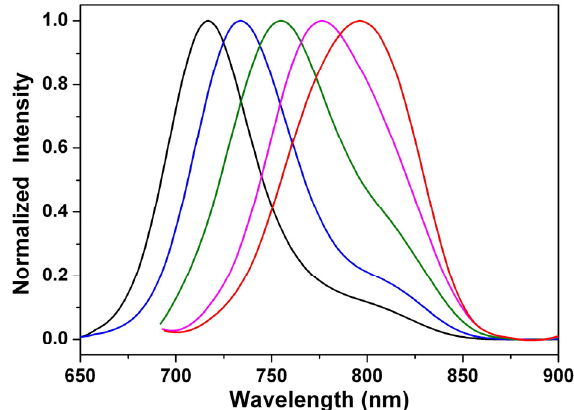
Figure 3. Normalized emission spectra of 1a – 4a in dichloromethane solution.